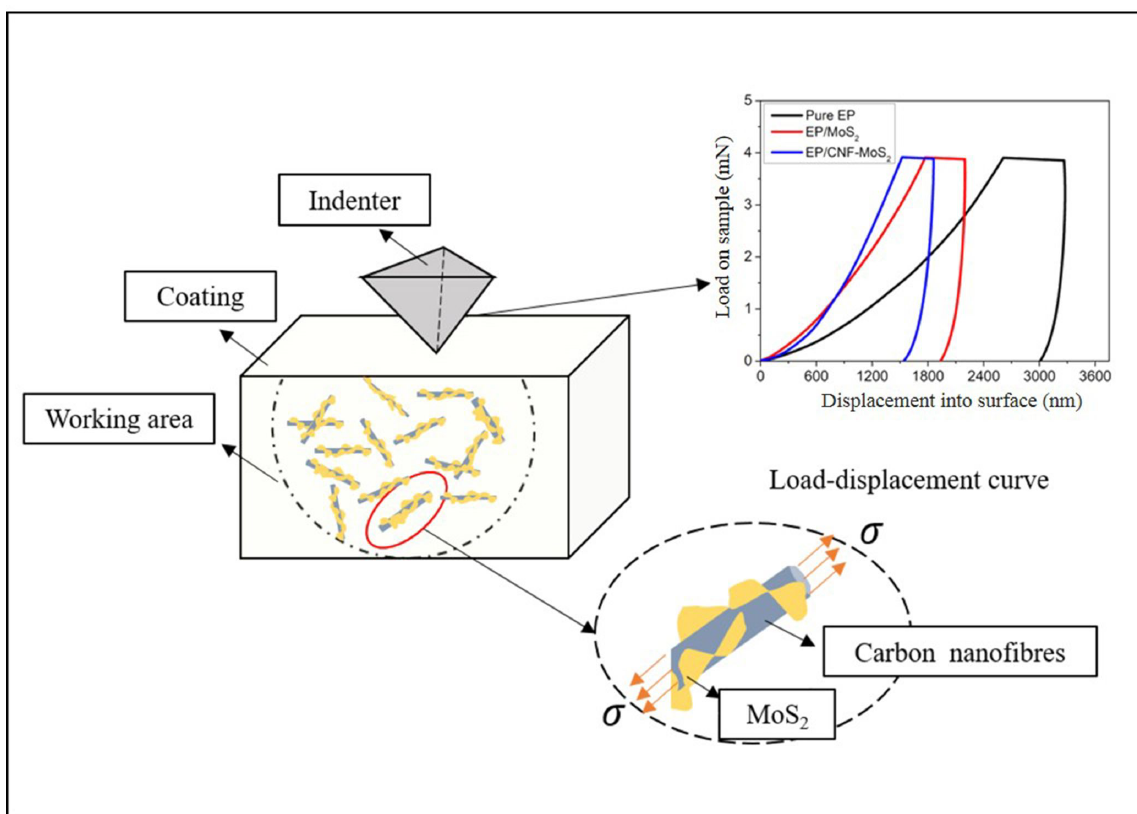
Figure 14: Schematic illustration of the indentation process of EP/CNF-MoS 2 composites